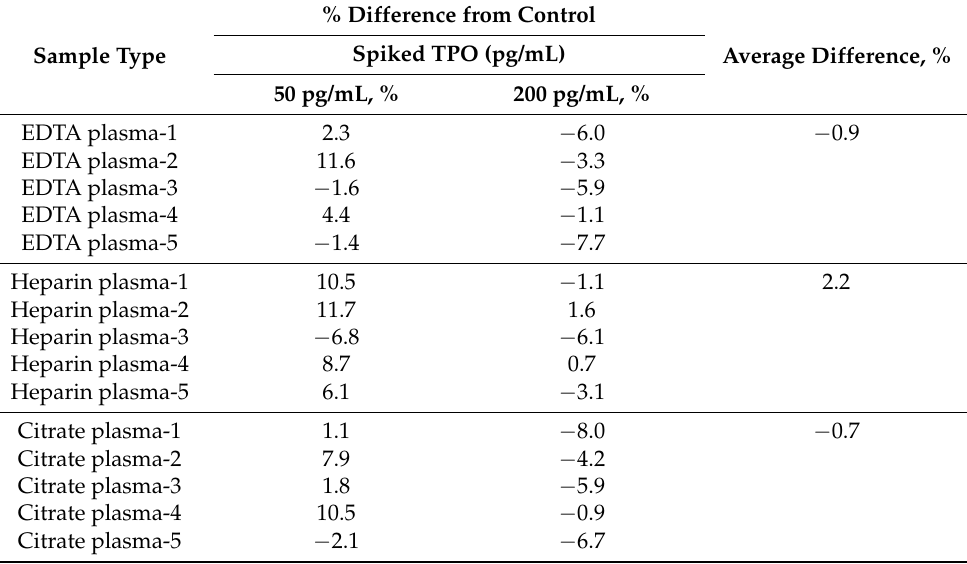
Table 5. Evaluation of plasma sample type equivalence using different